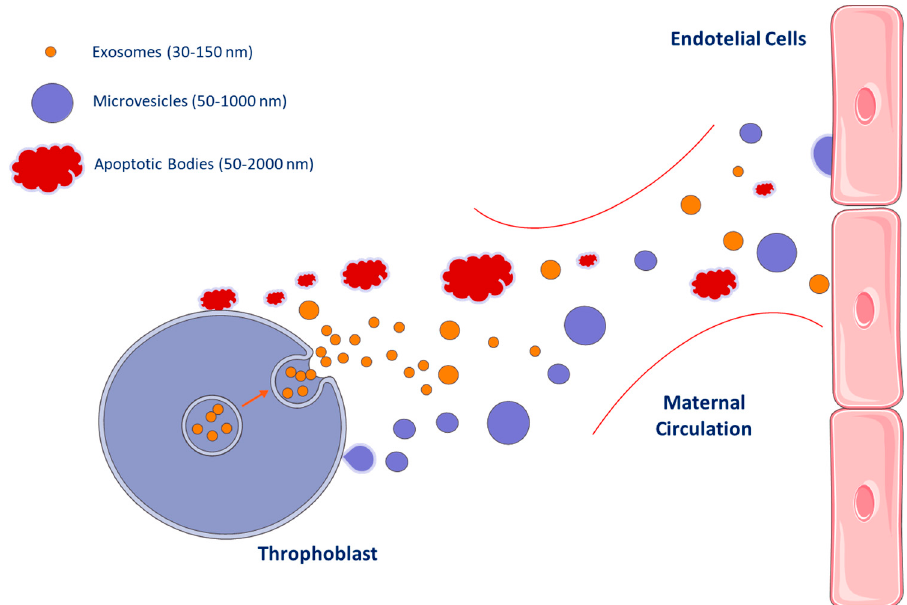
Figure 1. Extracellular vesicle sub-types released from placenta in normal pregnancies. Three main subsets of extracellular vesicles (EVs), with overlapping dimensions, have been traditionally described: Exosomes (orange, 30–150 nm) stem from the intracellular endosomal compartments and express tetraspanins; microvesicles (blue, 50–1000 nm) are produced by budding and express the phenotype of their parental cells; and apoptotic bodies (red, 50–2000 nm) are released by cells undergoing apoptosis and express phospatydilserine on their surface. As shown, the three EV subsets display overlapping dimensions. Under normal conditions, small numbers of EVs are released from the placenta and reach the maternal circulation. EVs participate in the crosstalk between feto–placental and mother tissues, with a relevant exchange of information. The appropriate function of those EVs guarantees successful pregnancies, as well as the healthy fetal development. This figure has been created from Servier